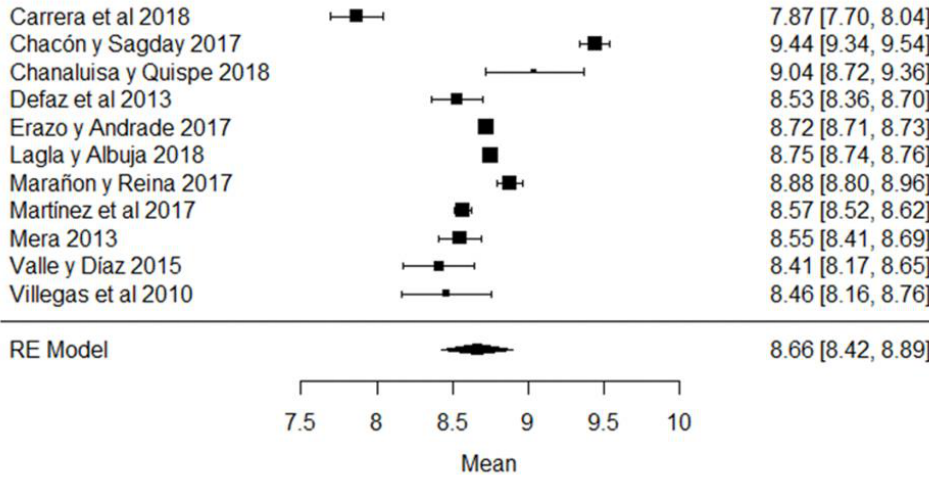
Figure 10. Forest plot of non-fat solids [38,39,42,44,51,61,63,73,77,79,80].